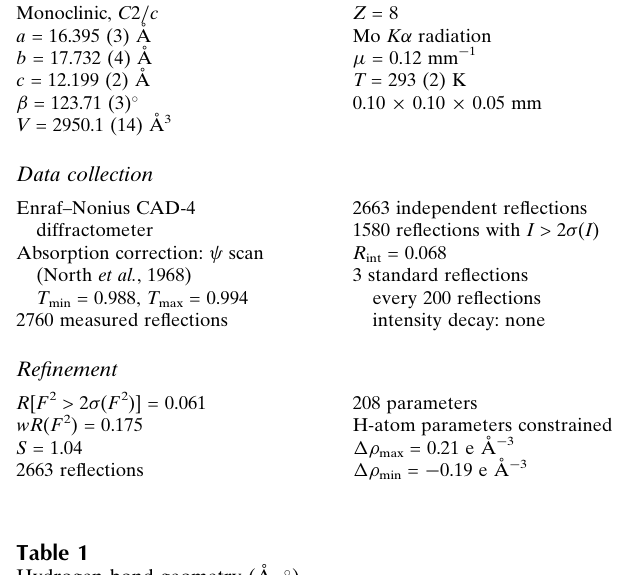
Hydrogen-bond geometry (A˚ , (cid:1)